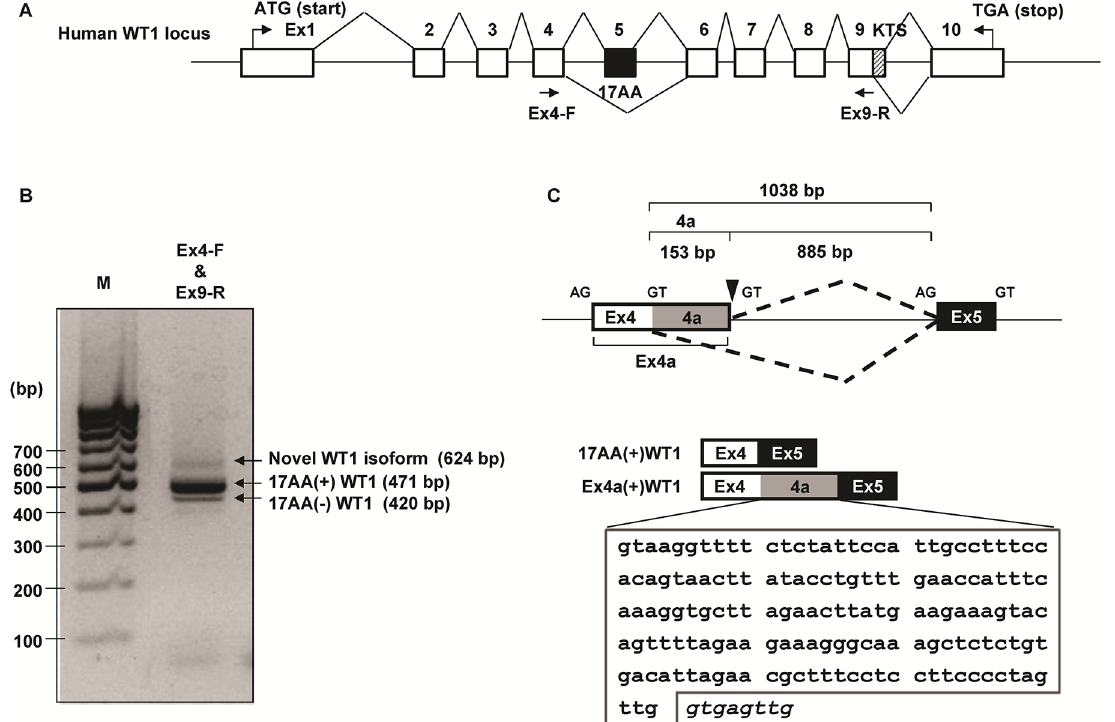
Fig 1. Isolation of a novel WT1 isoform. ( A ) Schematic representation of the human WT1 genomic structure (not to scale). Primers used for PCR amplification are indicated with arrows. Exons are shown as open boxes. Alternative splicing exon 5 (17AA) and KTS region in exon 9 are represented as black and hatched boxes, respectively. Translational start (ATG) and stop codons (TGA) are indicated. ( B ) Agarose gel electrophoresis of WT1 PCR products amplified using the primers indicated in (A) is shown. Bands were visualized by Gel-red staining. A novel transcript of 624 bp together with major WT1 isoforms, 17AA(+)WT1 (471 bp) and 17AA(-)WT1 (420 bp) were detected. Lane M, molecular marker (100 bp DNA ladder). ( C ) Upper, schematic representation of the WT1 genomic region encompassing exons 4 to 5, including the alternative splicing site in exon 4. Lower, schematic representation of the 17AA(+) and Ex4a(+)WT1 isoforms. Alternatively spliced exons 4a and 5 are shown in shaded and black boxes, respectively. DNA sequence of the newly identified 4a of 153 bp is expanded in the lower and surrounded by a solid line. Genomic sequences that follow immediately after the end of the 4a are shown in